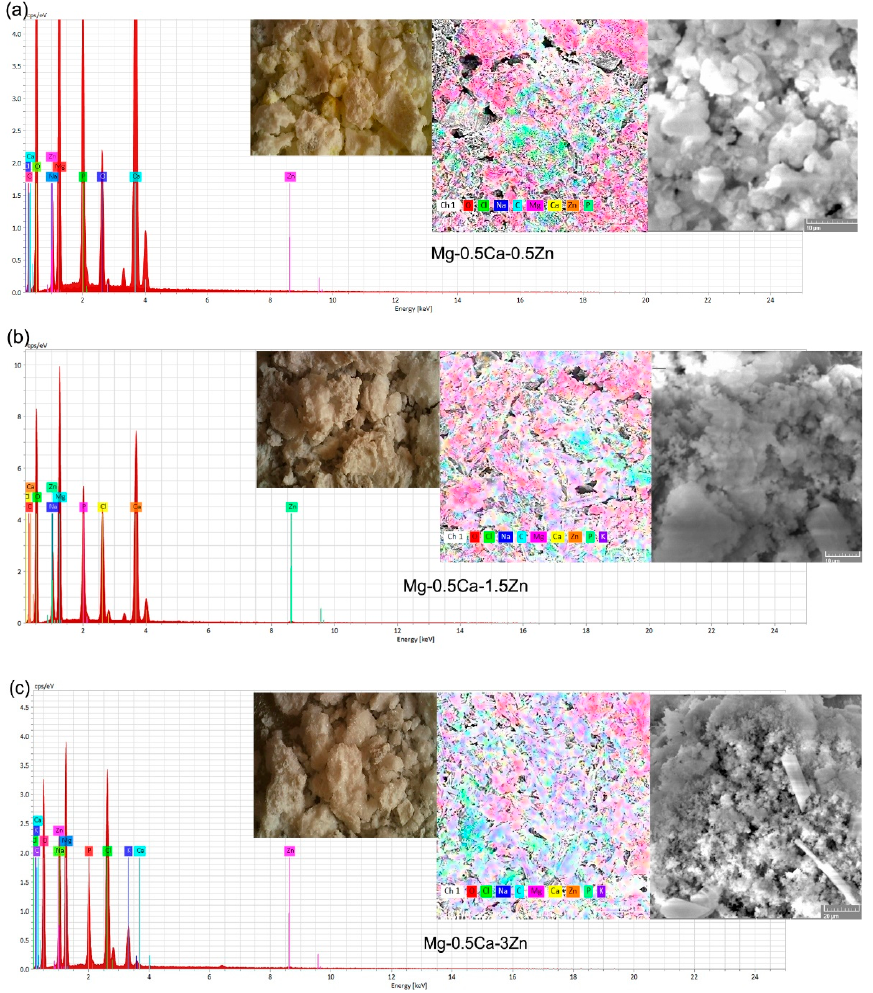
Figure 8. Morphology and chemical element distribution of the compounds that passed in the SBF solution after a five day immersion period: ( a ) Mg0.5Ca0.5Zn, ( b ) Mg0.5Ca1.5Zn, and ( c ) Mg0.5Ca3Zn.